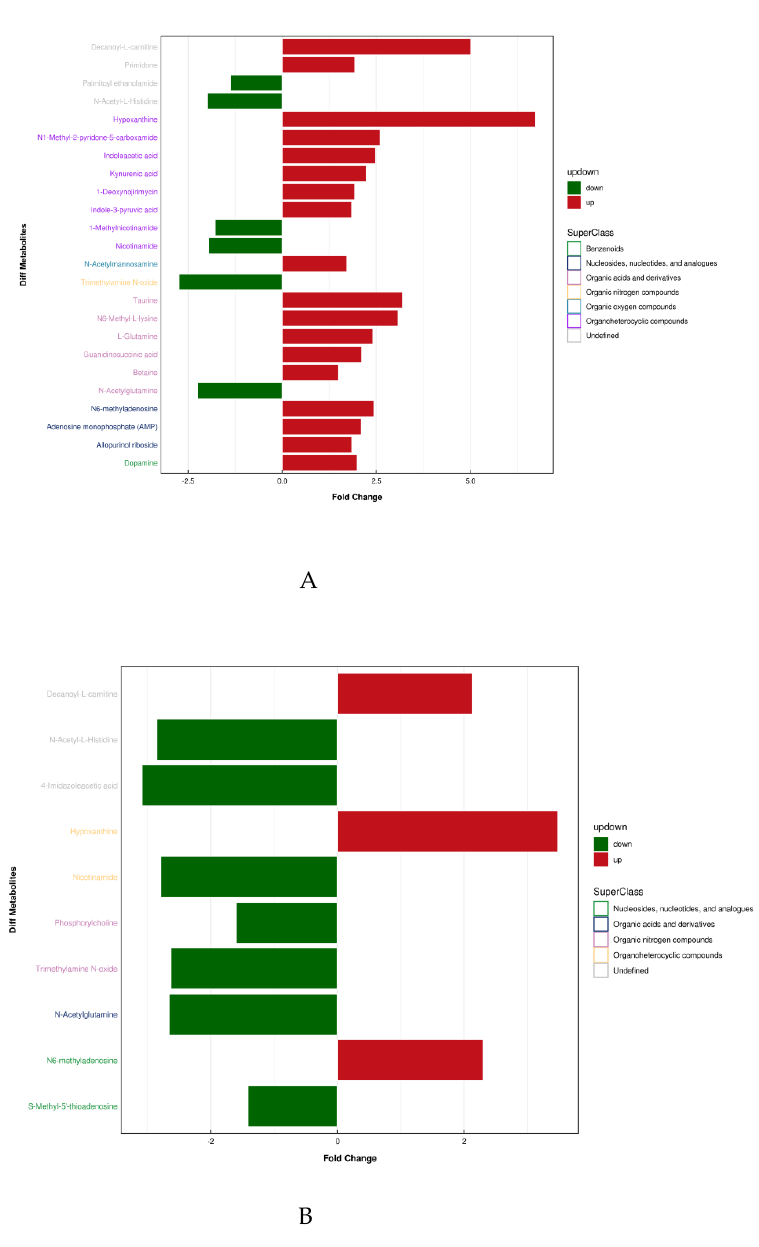
Figure 3. Differential metabolite super classification and FC diagram. (A: T2 vs T1, B: T3 vs T1).